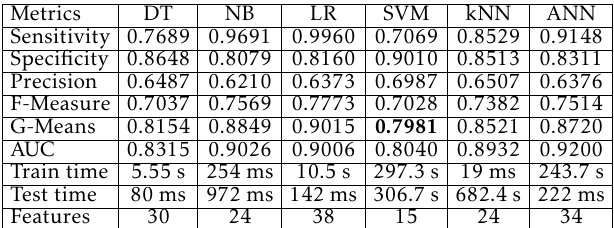
The results of using BFE on GENERIC class are shown in the Table 35, Table 36 and Table 37. The best feature reduction algorithm used is IG-BFE, the best machine learning algorithm used is DT, the number of remaining features after being reduced is 34. Table 38 compares the results of using IG-BFE with other